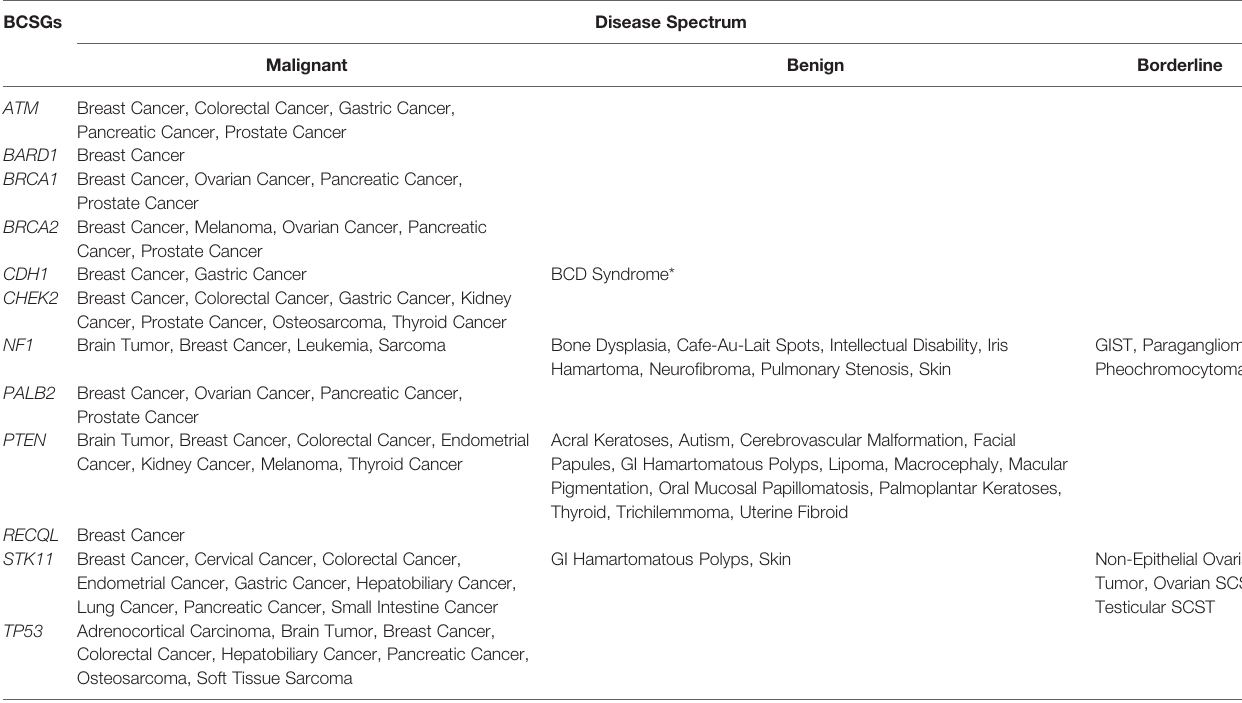
TABLE 2 | Diseases associated with the 12 breast cancer susceptibility